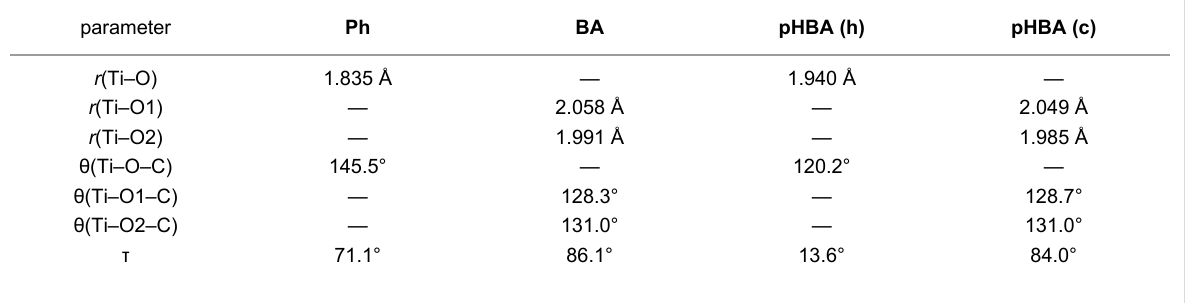
Table 2: Bond distances and bond angles relevant to the binding of the pollutants to the catalyst, after geometry optimization at DFT/B3LYP/3-21G* level; pHBA is anchored either through the hydroxy (h) or the carboxy (c) groups. parameter